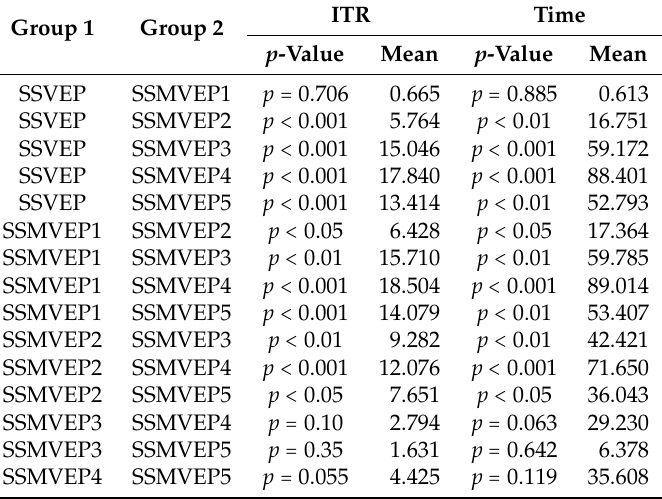
Table 3. Statistical results, p -values and mean differences, of the ITR performance measurement of the main task (18-trials) using paired t